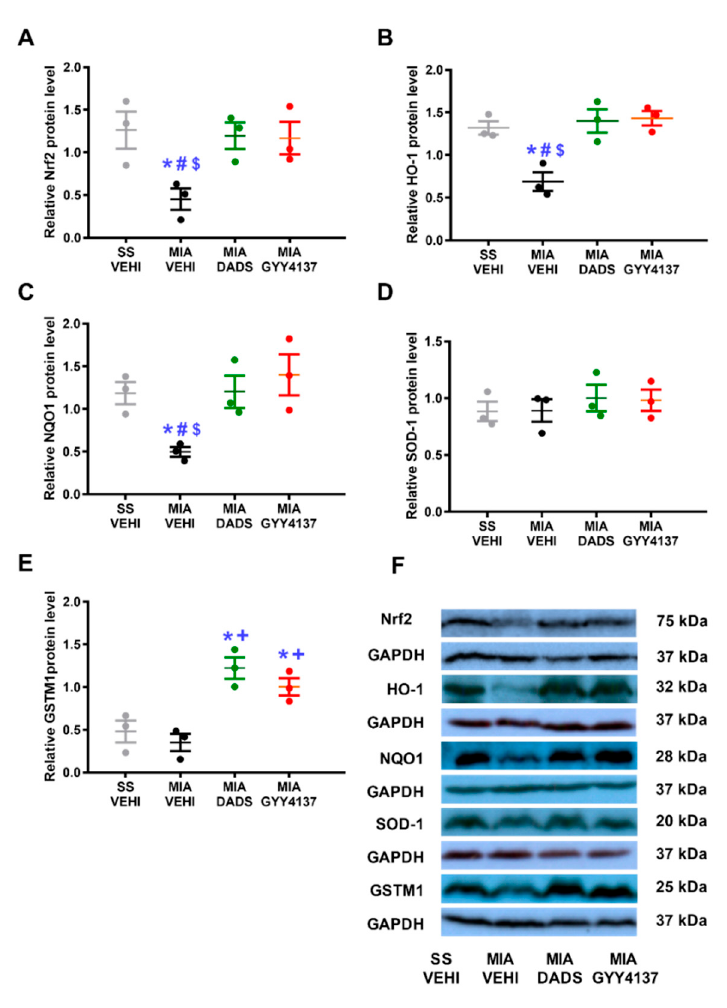
Figure 6. Effects of treatment with DADS and GYY4137 on the Nrf2, HO-1, NQO1, SOD-1, and GSTM1 protein levels in the PAG of MIA-injected mice. The expression of Nrf2 ( A ), HO-1 ( B ), NQO1 ( C ), SOD-1 ( D ), and GSTM1 ( E ) in PAG of MIA-injected animals treated with vehicle (MIA-VEHI), DADS (MIA-DADS) or GYY4137 (MIA-GYY4137) and of SS-injected mice treated with vehicle (SS- VEHI) are represented. All proteins are expressed relative to GAPDH levels. For each protein, * indicates significant differences vs. SS plus vehicle-treated mice; + vs. MIA plus vehicle-treated an- imals; # vs. MIA plus DADS-treated mice and $ vs. MIA plus GYY4137-injected mice ( p < 0.05, one- way ANOVA; Student–Newman–Keuls test). Examples of blots for Nrf2, HO-1, NQO1, SOD-1, GSTM1, and GAPDH are shown ( F ). Results are displayed as the mean ± SEM ( n = 3 samples). 4. Discussion This study revealed that the acute administration of an HO-1 inducer, a CO releasing molecule or H 2 S donors inhibited the mechanical allodynia in a dose-dependent manner, but only H 2 S donors inhibited the grip strength deficits caused by joint degeneration. Moreover, the co-administration of low dose of CORM-2 or CoPP with DADS or GYY4137 potentiated the antiallodynic actions as well as the recovery of grip strength produced by each of these compounds. Thus, this suggests a positive interaction between H 2 S and CO on the modulation of joint pain. Our data also revealed the involvement of the Nrf2/HO-